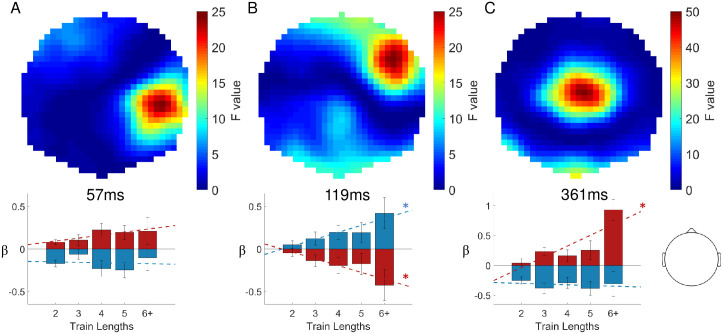
Statistical parametric maps of mismatch responses.Top row: Topographical F maps resulting from contrasting standard and deviant conditions averaged across the times of significant clusters: 57ms (A), 119ms (B) and 361ms (C). Bottom row: Corresponding beta parameter estimates of the significant peaks with deviants in red and standards in blue. Asterisks indicate significant linear fits (p < 0.05). Head depiction on the bottom right shows the orientation of the topographic maps.